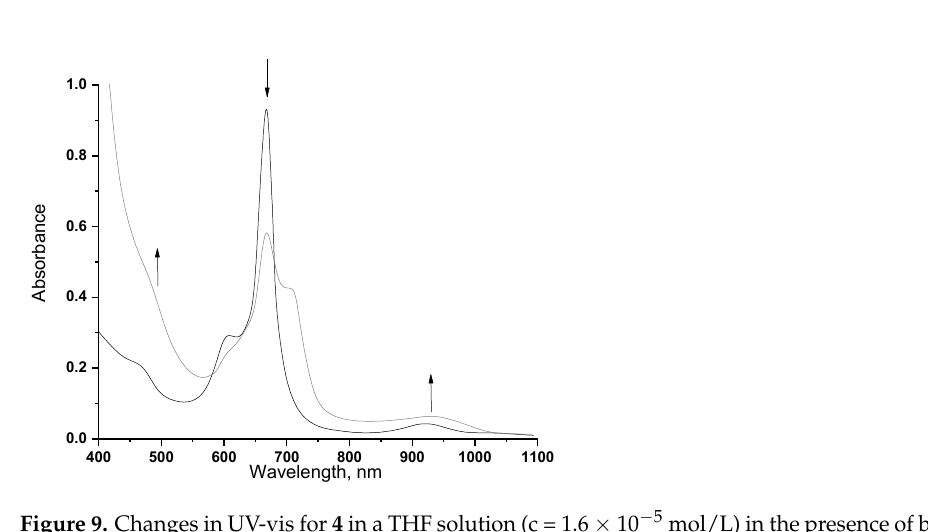
Figure 9. Changes in UV-vis for 4 in a THF solution (c = 1.6 × 10 − 5 mol/L) in the presence of (c = 3.9 × 10 − 3